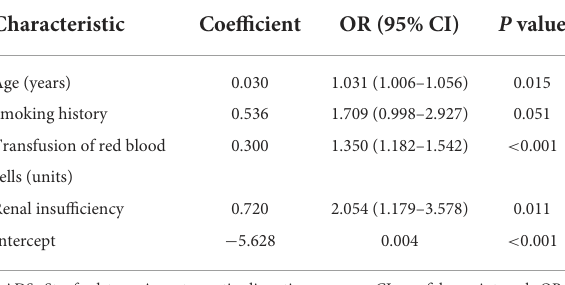
TABLE 2 Multivariable analysis of significant predictors for reintubation after